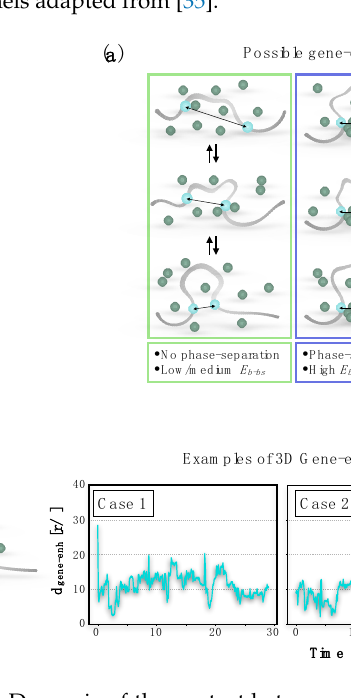
Figure 2. Dynamic of the contact between regulatory elements. ( a ) The affinity between binding sites and binders influences the contact during time and different dynamics emerge. ( b ) Different examples of contact dynamics obtained from Molecular Dynamics simulations, for a moderate affinity E b-bs = 3.1 KBT (E b-b = 3.0 KBT). The contact is stable, but the binding sites can move on the cluster and can also detach. Adapted from